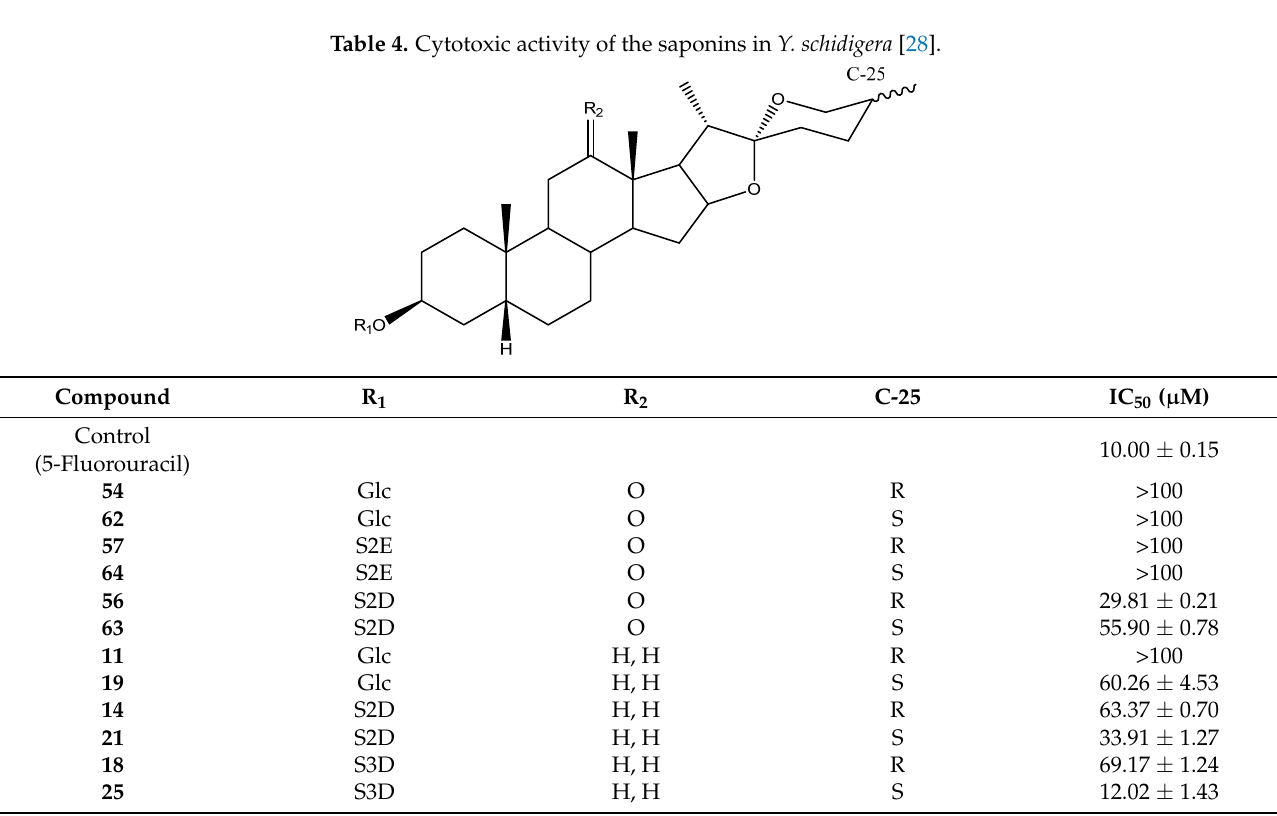
Table 4. Cytotoxic activity of the saponins in Y. schidigera [28].